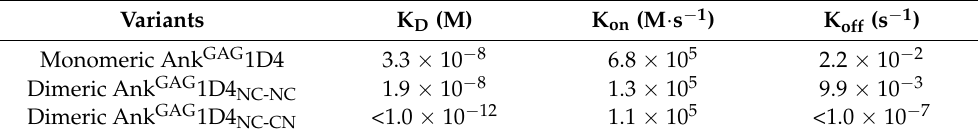
Table 2. Kinetic characterization of monomeric and dimeric Ank GAG